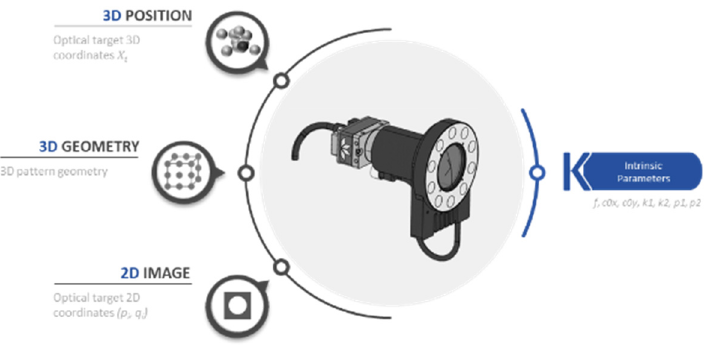
Figure 4. The factors that affect the correct determination of the intrinsic parameters are the 3D position, 3D geometry and 2D